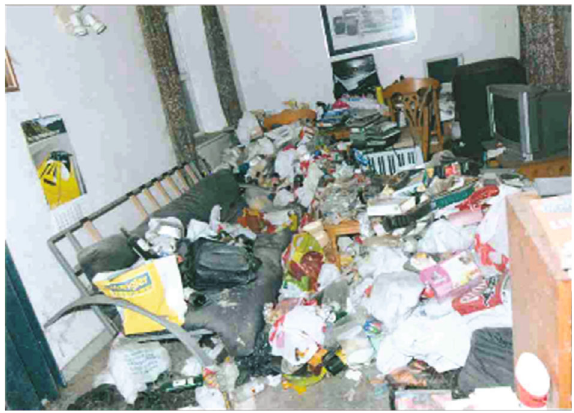
Figure 2: Living